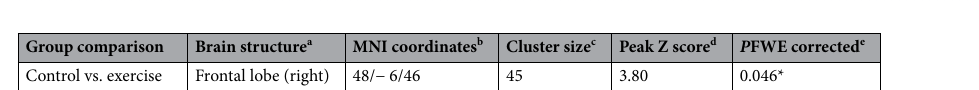
Figure 2. ( A – C ) Changes in cognitive performance in patients with obstructive sleep apnea in the control group and exercise-trained group. CSWT , Stroop Color Word Test; FAB , Frontal Assessment Battery; TMT , Trail Making Test. * P < 0.05 control versus training group.